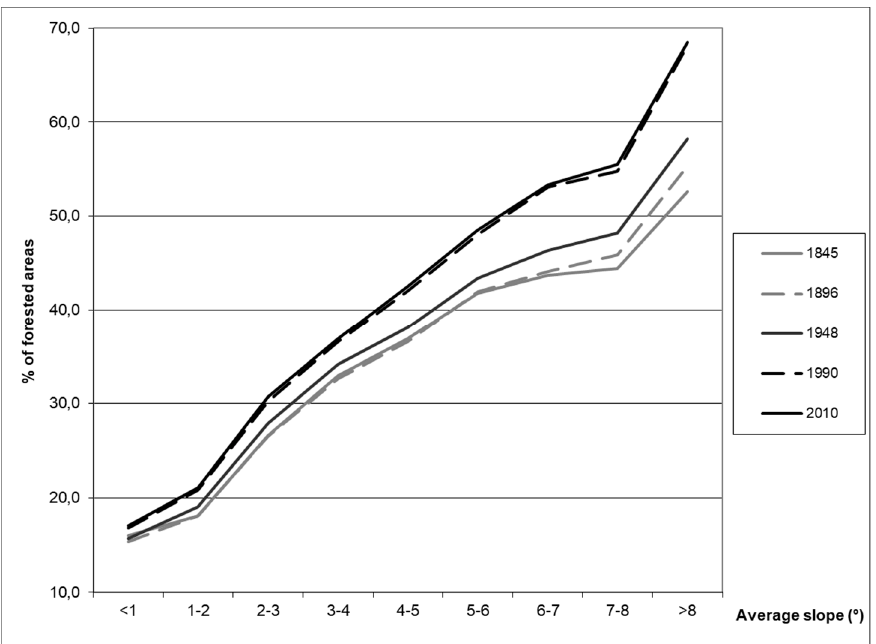
Figure 7. Changing share of forested areas (%) according to average slope of BTUs. Source: own calculation, LUCC Czechia database.